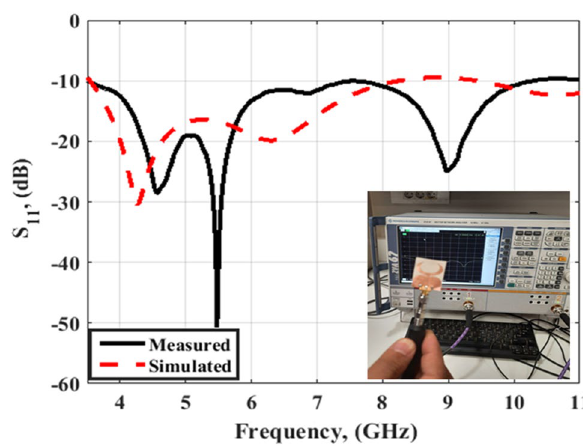
Figure 2. S 11 outcomes of the flexible single antenna.